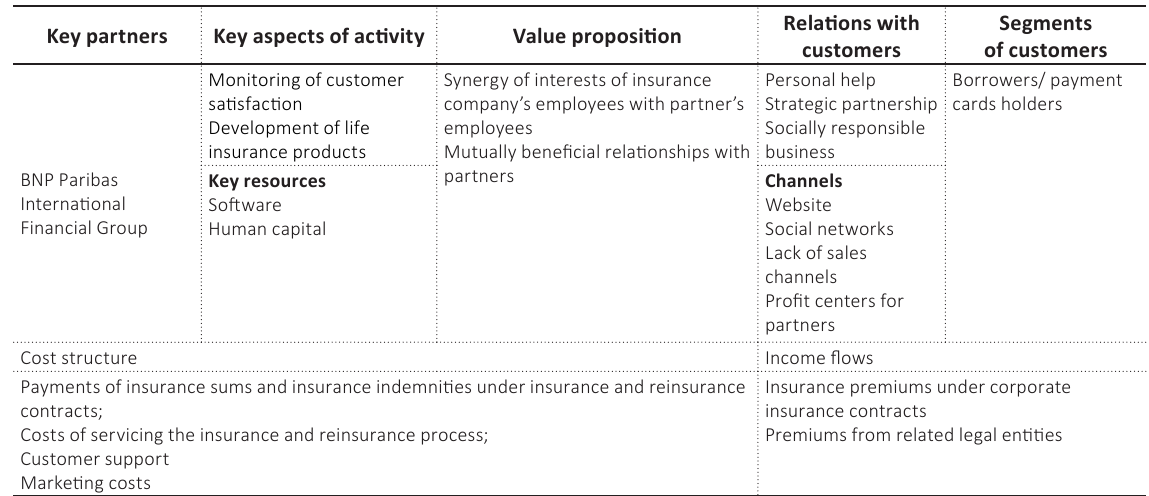
Table 8. Business model of Cardiff Insurance